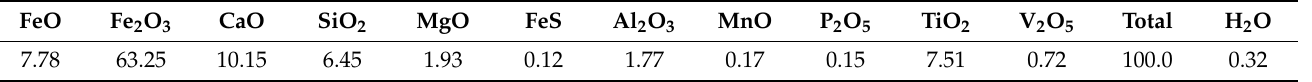
Table A5. Mixed ore composition for calculation